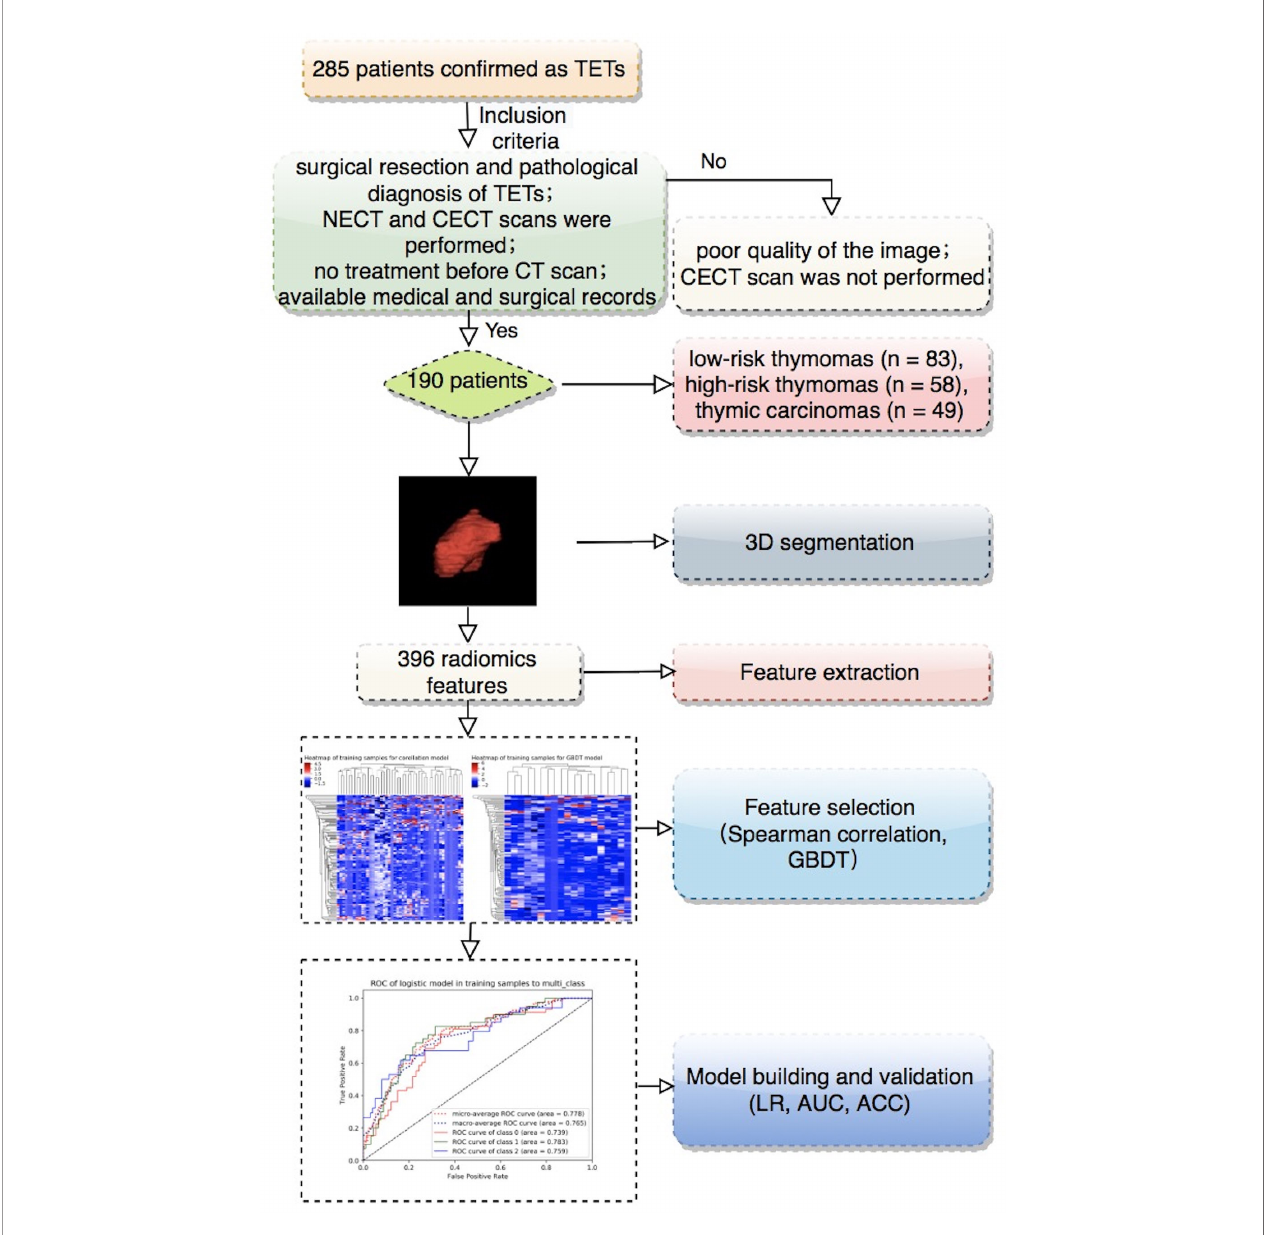
FIGURE 1 | The work fl ow of this